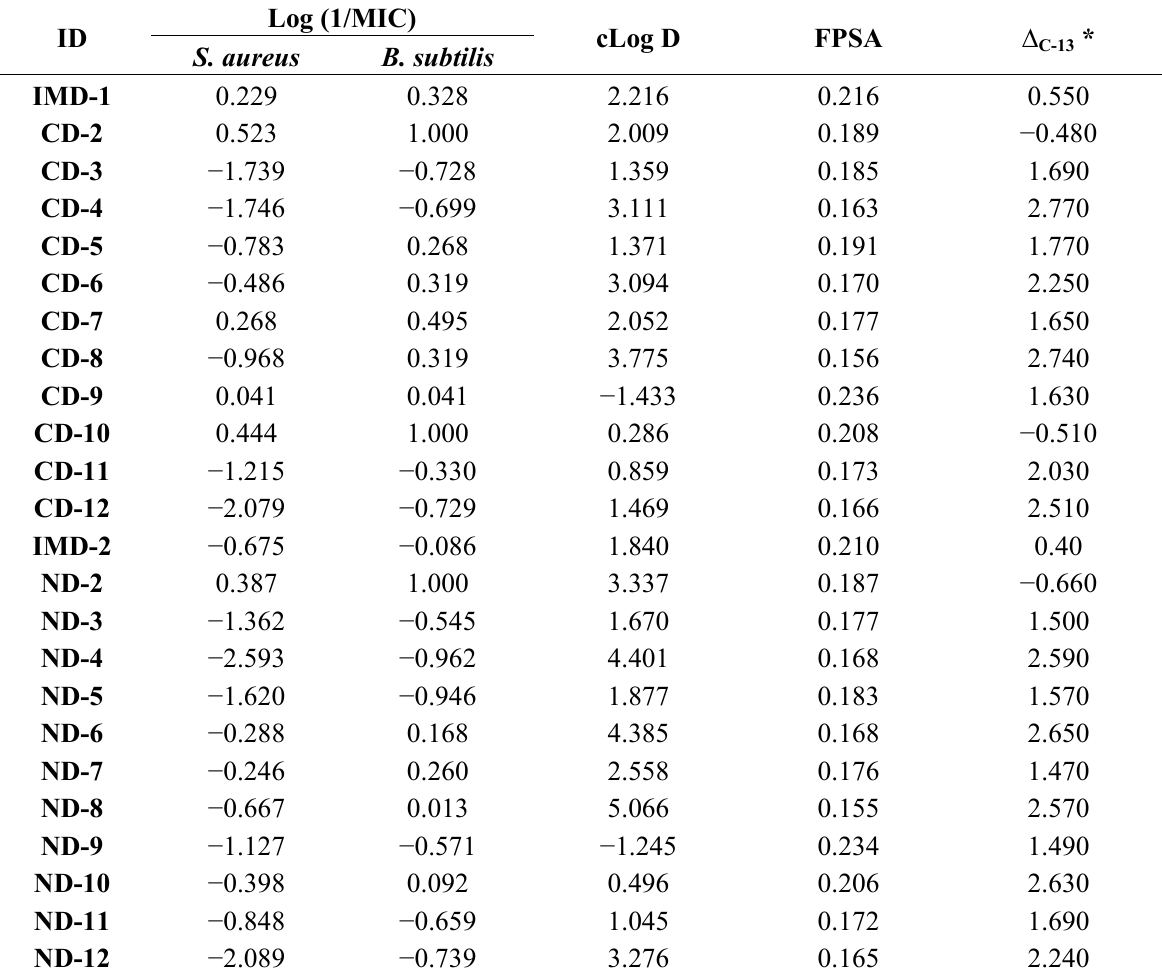
Table 2. Log (1/MIC), clog D, molecular fractional polar surface area (FPSA) and ∆